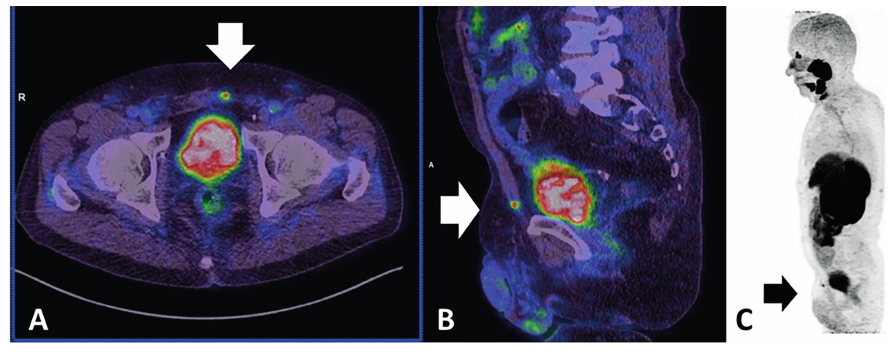
Figure 6 - Abdominal wall